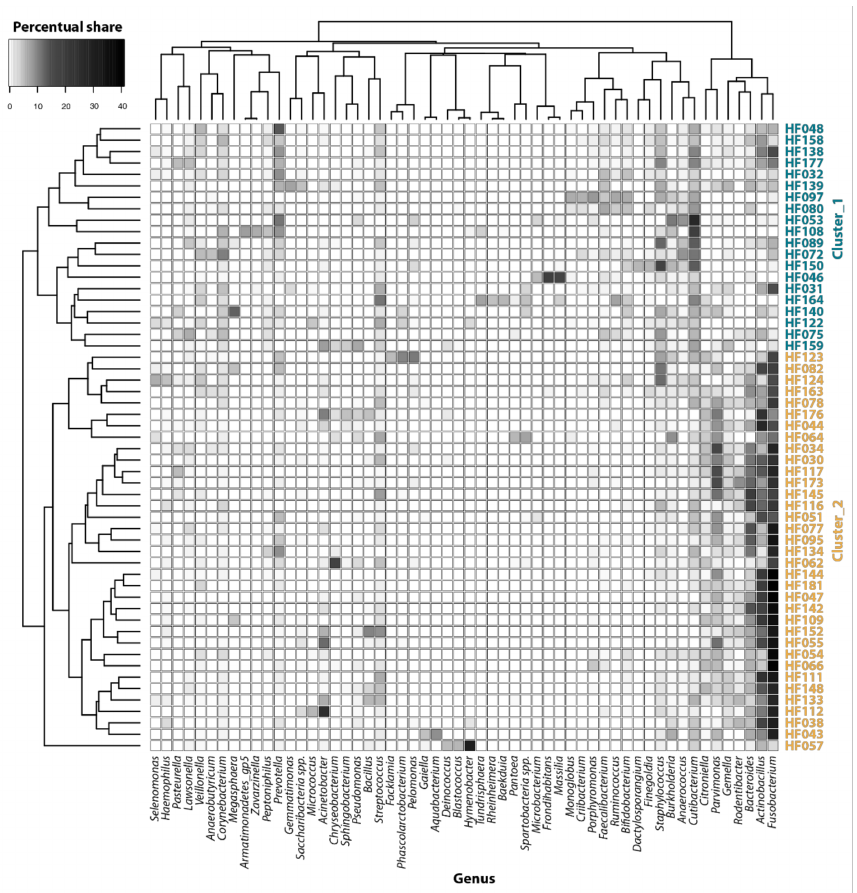
Figure 4. Heatmap of the most abundant bacterial genera (at least 5% of any sample) present in the ejaculates of clinically healthy breeding